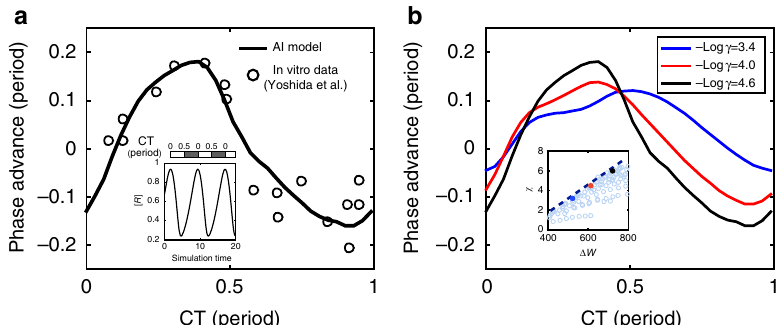
Fig. 6 Experimental connection and prediction of the dependence of phase sensitivity on irreversibility γ . a By assuming k 1 is increased by 70% and k 4 by 30% during a temperature up perturbation (0.1 period), the PRC from the AI model (black line) can be fi tted to that of a temperature up PRC (symbols) observed in 57 . Simulation trajectory of oscillation along with the circadian time scale are shown in the inset. The peak of activator rhythm is de fi ned as CT 0. Experimental PRC data from ref. 57 is aligned with the model PRC to peak at the same CT. b PRCs for the same perturbation as in a is computed for different background levels of ATP/ADP ratio or equivalently different values of γ (given in the legend). The extra free-energy dissipation for each γ choice are: Δ W − W c ≈ 170 (blue); 250 (red); 350 (black, same as in a ). Amplitude of PRC increases as sensitivity χ is enhanced by (cid:2) log γ or Δ W as shown in the inset, where the hollow circles correspond to different choices of ( γ 1 , γ 2 ). This prediction can be tested